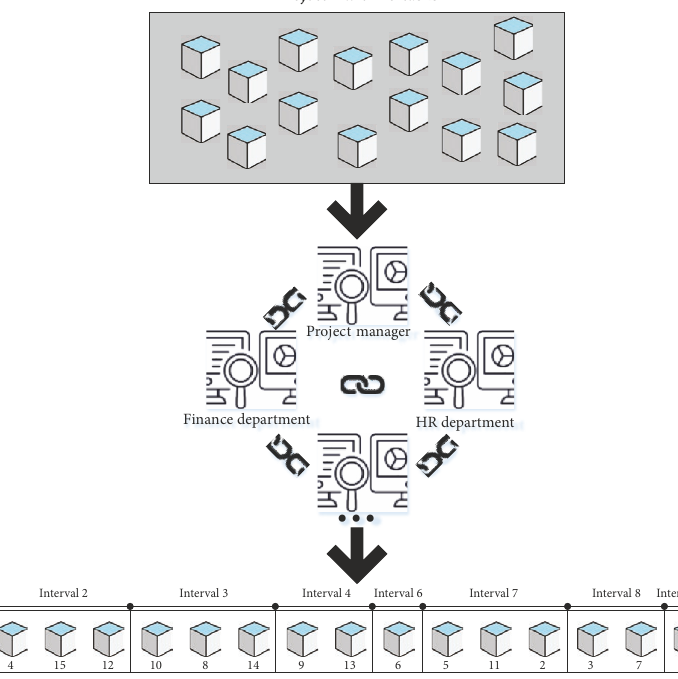
Figure 11. Chaining of optimal blocks project 1 using normally